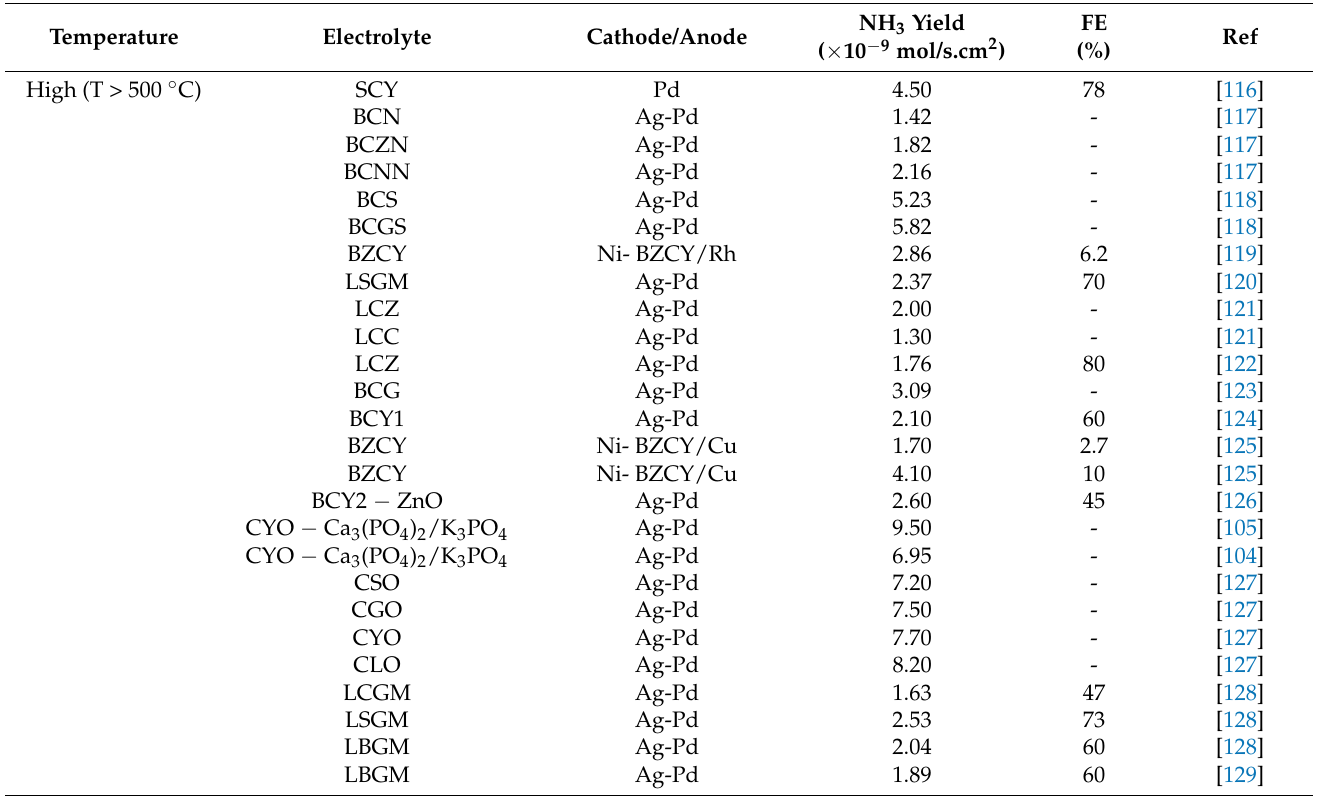
Table 8. A summary of the selected electrocatalytic ammonia synthesis by previous studies. Temperature